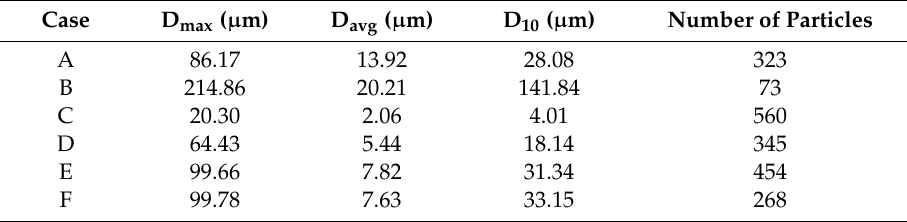
Figure 7. Particle images for cases ( A ): raw water with pH 5, ( B ): water with pH 5 with a dosage of 5 mg / L at the end of flocculation, ( C ): water with pH 5 with a dosage of 5 mg / L at the end of sedimentation, ( D ): raw water with pH 8, ( E ):water with pH 8 with dosage of 45 mg / L at the end of flocculation and ( F ): water at pH 8 with a dosage of 45 mg / L at the end of sedimentation. Table 9. Quantitative characterization of particles for cases A, B, C, D, E and F.